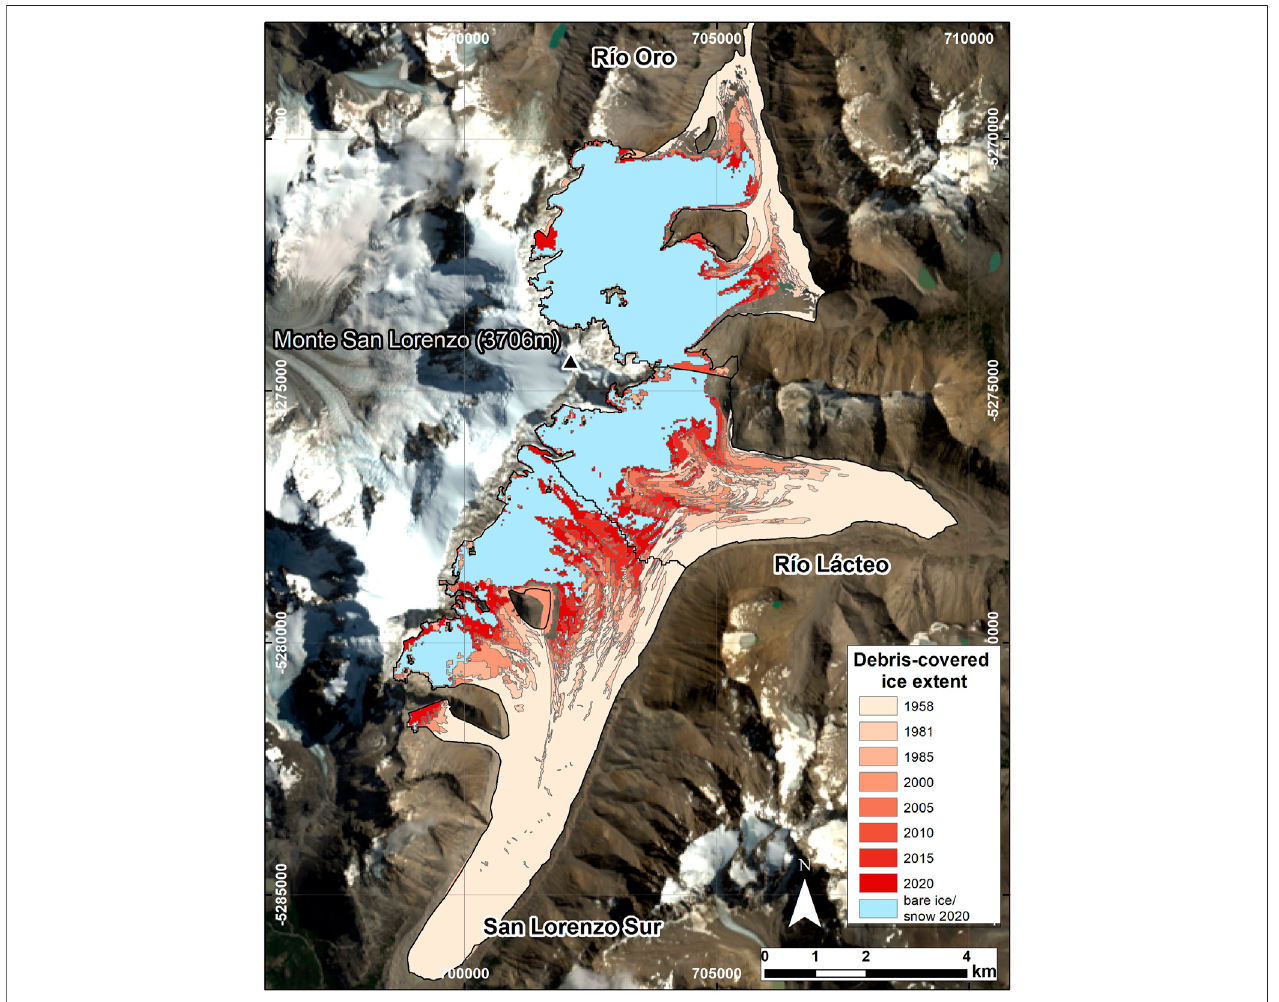
FIGURE 2 | Evolution of the debris-covered ice extent through time and the remaining bare ice and snow. Background image is a 2020 Landsat 8 RGB 654 false color composition.